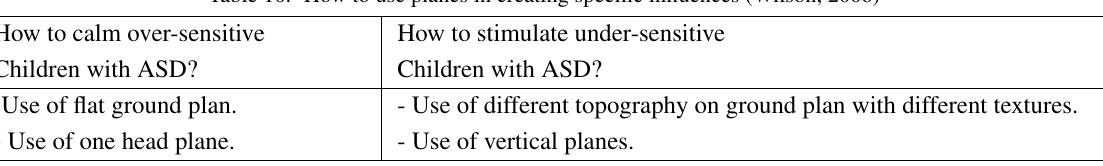
Table 10. How to use planes in creating specific influences (Wilson, 2006)